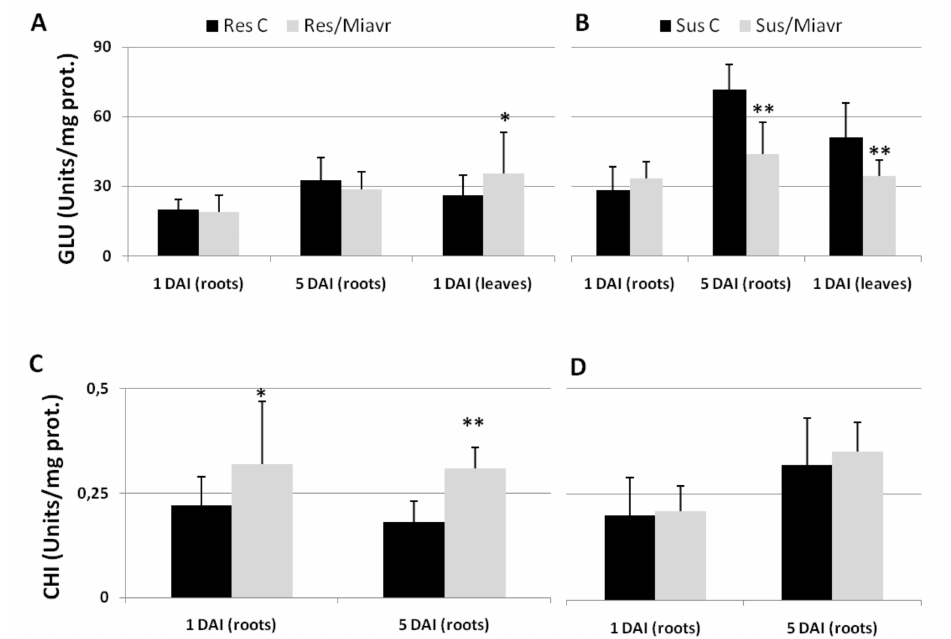
Figure 7. Defense enzyme activities of resistant (Res C) and susceptible (Sus C) un-inoculated control plants and of plants inoculated with the avirulent field population Mi-Vfield (Res / -Sus / Miavr) or with the virulent isolate SM2V (Res / Mivir). Glucanase (GLU— A , B ), and chitinase (CHI— C , D ) activities are expressed as Units mg -1 prot. Protein extraction was carried out using roots 1 and 5 DAI and using leaves 1 DAI, as it concerned GLU; CHI was assayed only in roots 1 and 5 DAI. Values are shown as means ( n = 9) ± SD. Means coming from the inoculated roots were separated from those of un-inoculated control roots by a t -test; asterisks indicate significant di ff erence (* p < 0.05; ** p <